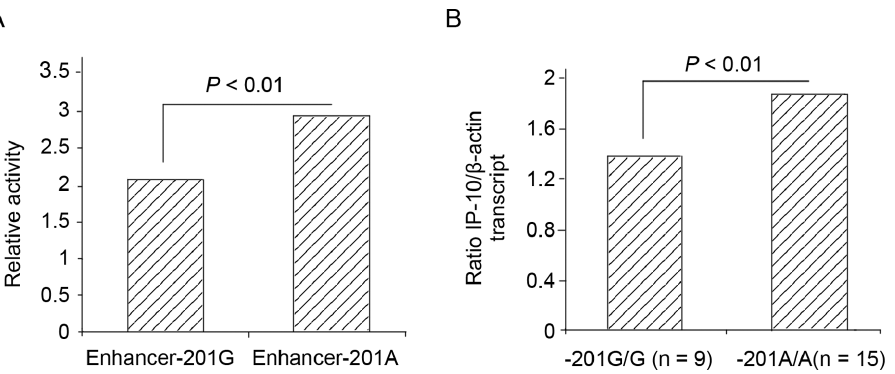
Figure 1. Correlation of IP-10 expression with the allele and genotype. (a) Luciferase activity in HepG2 cells transfected with promoter- reporter vectors corresponding to -201GG or AA haplotype homozygotes, respectively. The vertical axis represents the relative proportion of luciferase activity to corresponding pGL3-enhancer vectors. Data represent mean of representative data from three experiments performed in quadruplicate. P values were estimated by Student t test. (b) Expression of CXCL10 measured by quantitative SYBR PCR of RNAs purified from peripheral blood mononuclear cells of 24 patients. Columns, mean from triplicate measurements; bars, SD.